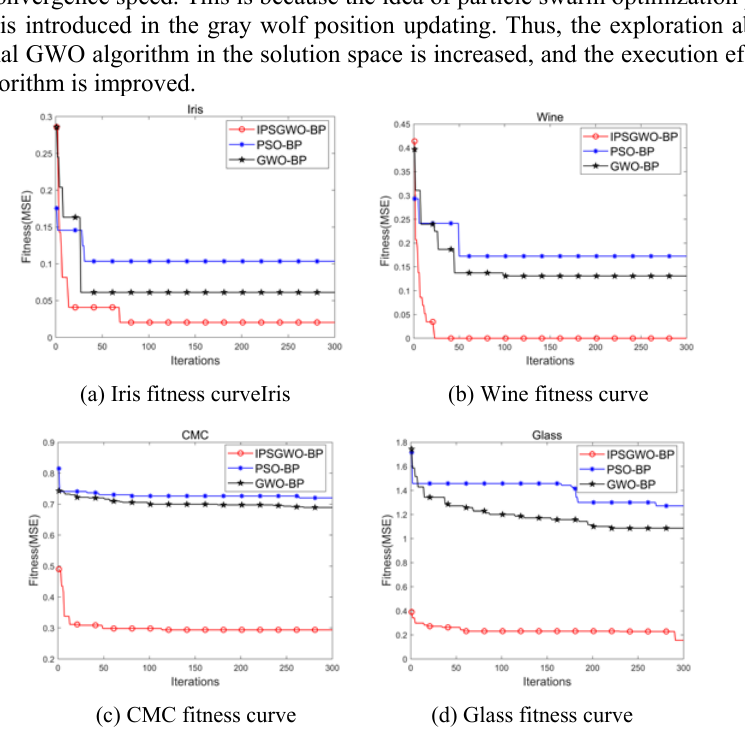
Fig. 1. Comparison of fitness functions of the three